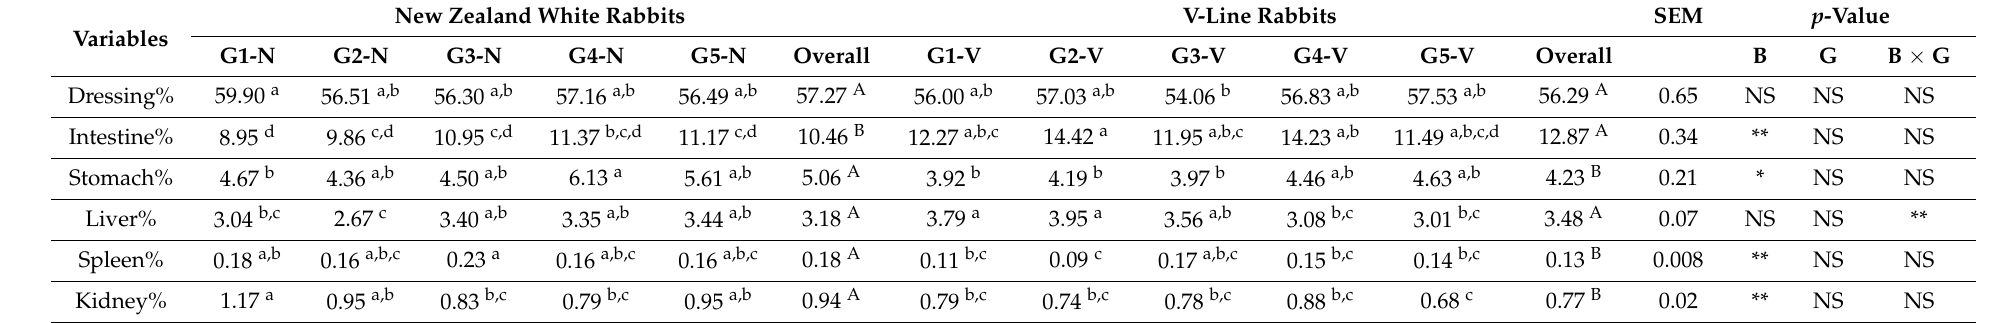
Table 7. Carcass changes of the New Zealand white and V-line rabbits in response to coccidial infection and herbal extract treatment.